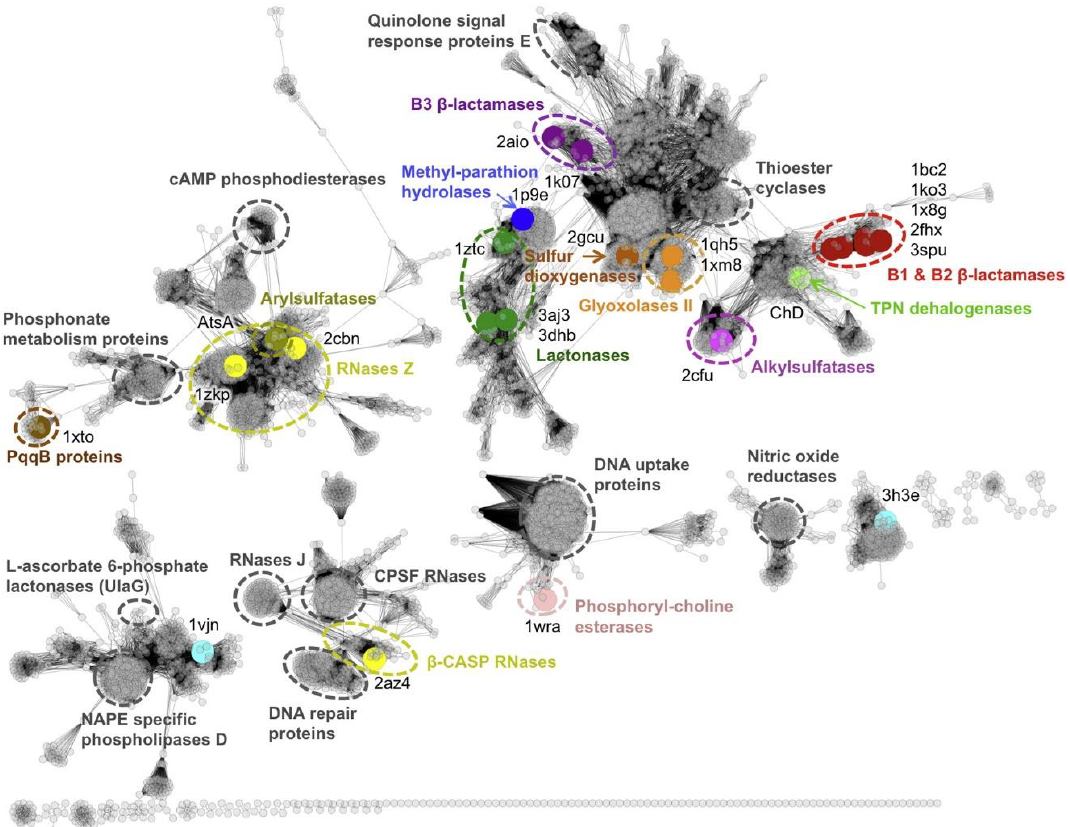
Figure 1. Sequence similarity network of metallo-β-lactamase (MBL) superfamily members. A total of 6233 sequences (nodes) and lines (edges) show a sequence relationship at a BLAST e-value cutoff of 1 × e − 14 . Large colored nodes show sequences that were experimentally characterized with colored broken circles indicating their approximate functional family cluster. Pale-blue-colored nodes (PDB IDs 1vjn and 3h3e) are experimentally characterized sequences with unknown function and from clusters with unknown function. The functional family clusters of three experimentally characterized sequences have not been encircled due to the small number of functional homologs (methyl-parathion hydrolase and TPN dehalogenase) and annotation ambiguity (sulfur dioxygenase). Gray broken circles indicate functional sequence clusters that have been experimentally characterized and reported in the literature but have not been included in this study. For unassigned gray sequence clusters (not encircled), no confident functional information could be retrieved from the databases or literature. This figure has been reprinted with permission from Baier and Tokuriki [13].